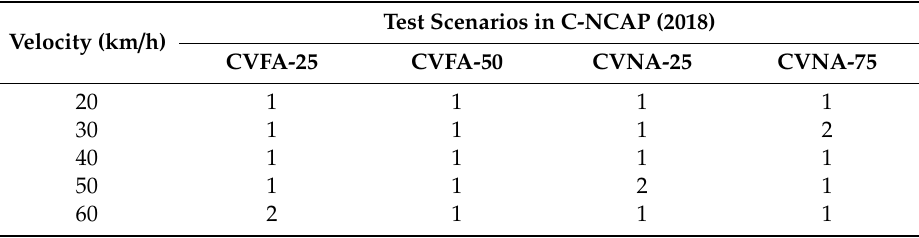
Table 6. Testing the cooperative control between the dummy traction system and ADR.